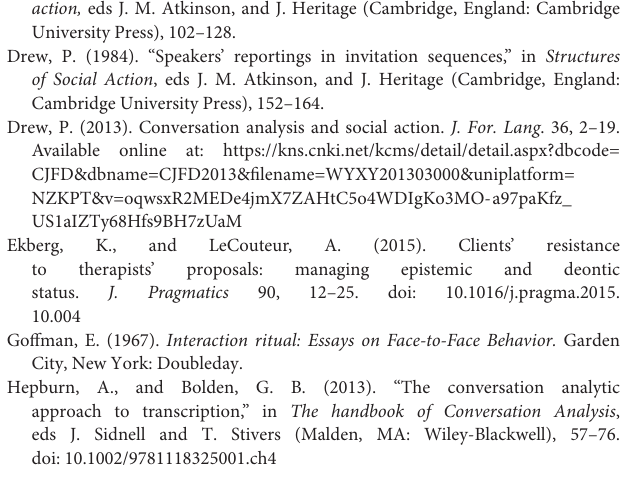
that normally the proposer would not do it. Also, this suggests that canceling may not be an appropriate